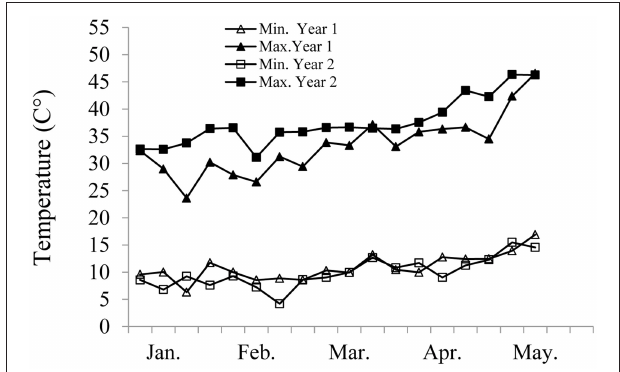
FIGURE 1 | Average weekly minimum and maximum temperatures measured in the screen house in Year 1 and Year